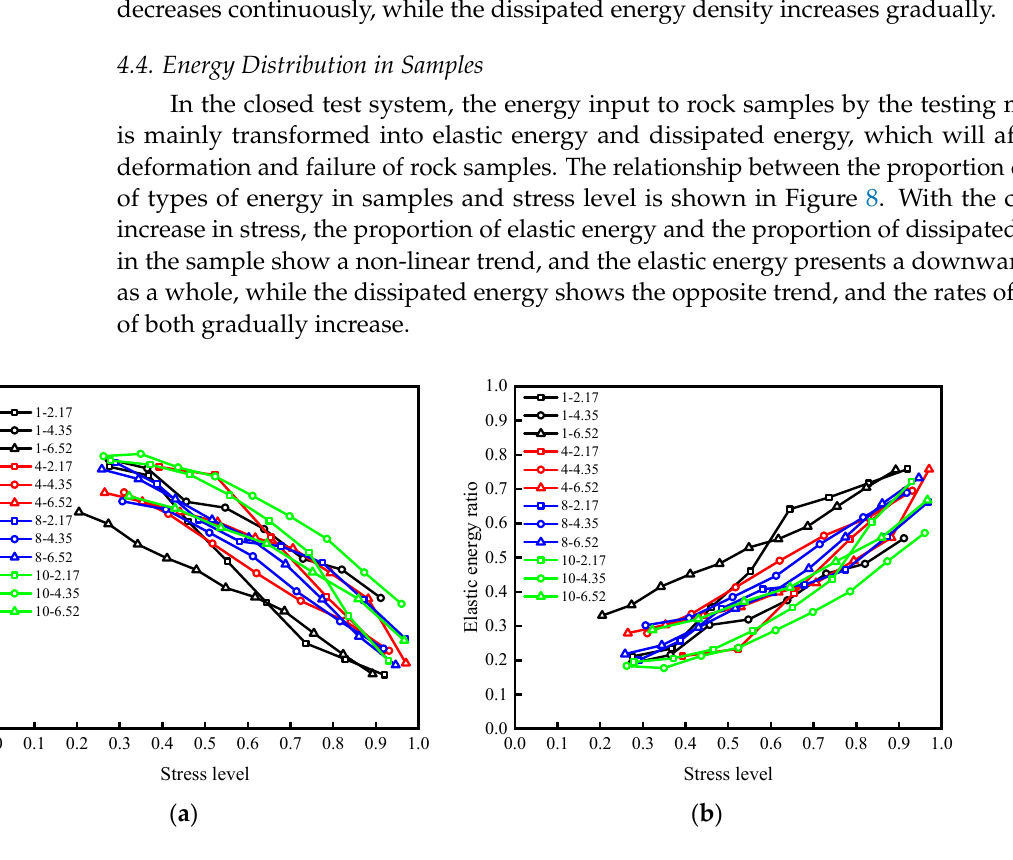
Figure 8. Relationship between energy ratio and stress level under different working conditions: ( a ) u e ; ( b ) u d .